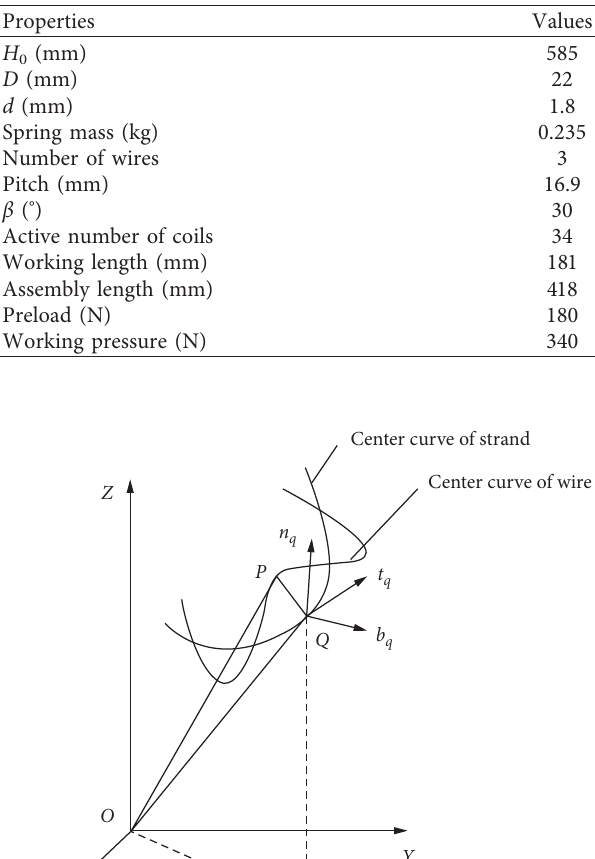
Figure 1: Geometric model of three-wire recoil spring. Table 1: Parameters of three-wire recoil spring.